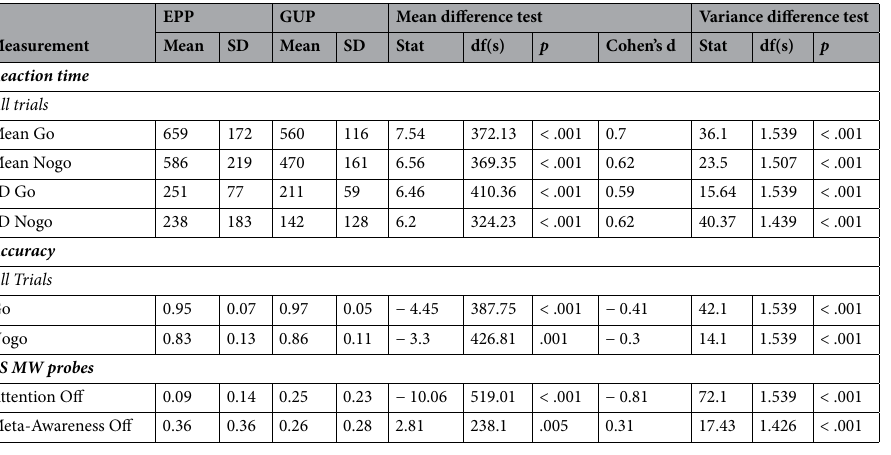
Table 2. Sample difference tests. Samples sizes were n = 228 and n = 313 for the EPP and GUP sample, respectively. For brevity, we only report parametric tests here even though several of the variables show a non- normal distribution. Non-parametric tests (Mann–Whitney U tests instead of t tests for mean differences and Brown–Forsythe tests instead of the Levene’s tests for variance differences) showed a similar overall pattern of results, see Table S8 in the supplementary materials at https:// osf. io/ 8kg6z). SD = standard deviation, EPP = English-speaking paid participants, GUP = German-speaking unpaid